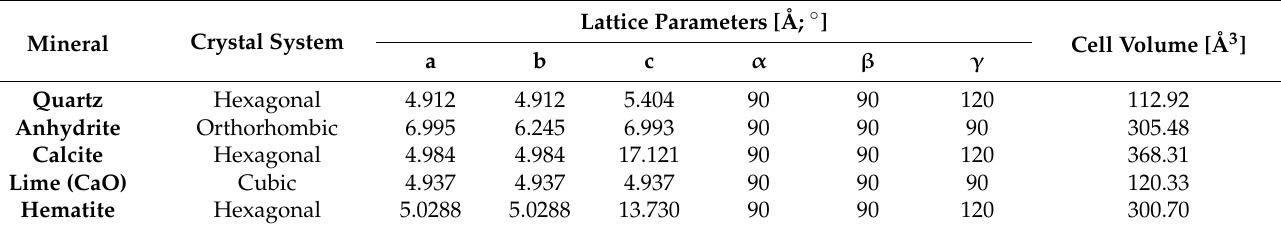
Figure 1. Mineralogical composition of the used CCFA (CCFA-H) via XRD patterns. Figure 2a,b represents the microstructure of the used CCFA. The anhydrite crystal can be seen in Figure 2b marked with letter A, the other fine particles were located in clusters and contained quartz, hematite, calcite, and amorphous aluminosilicate particles.